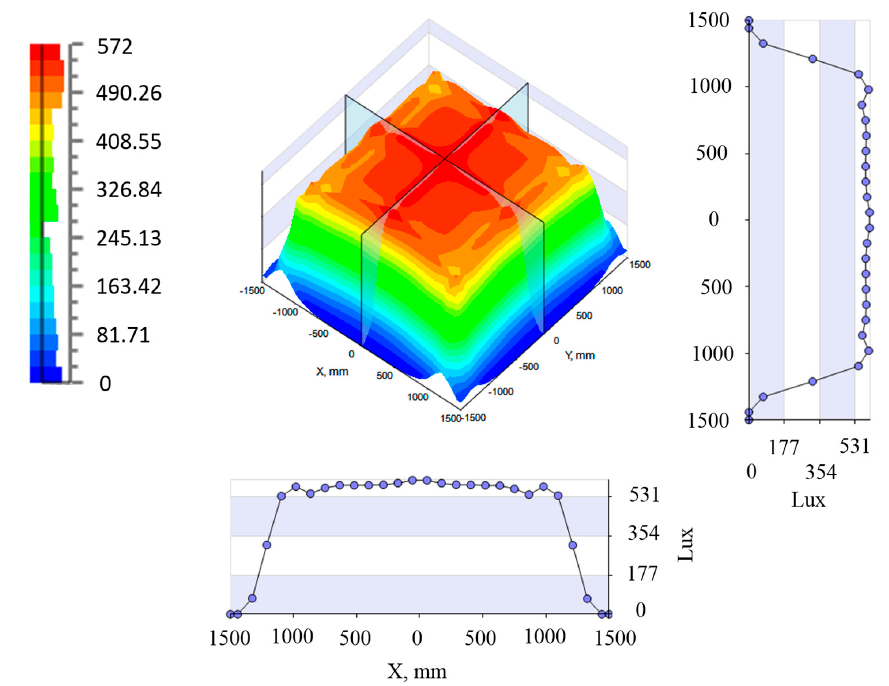
Figure 14. Irradiance distribution of designed distributor on working plan 2 × 2 m.